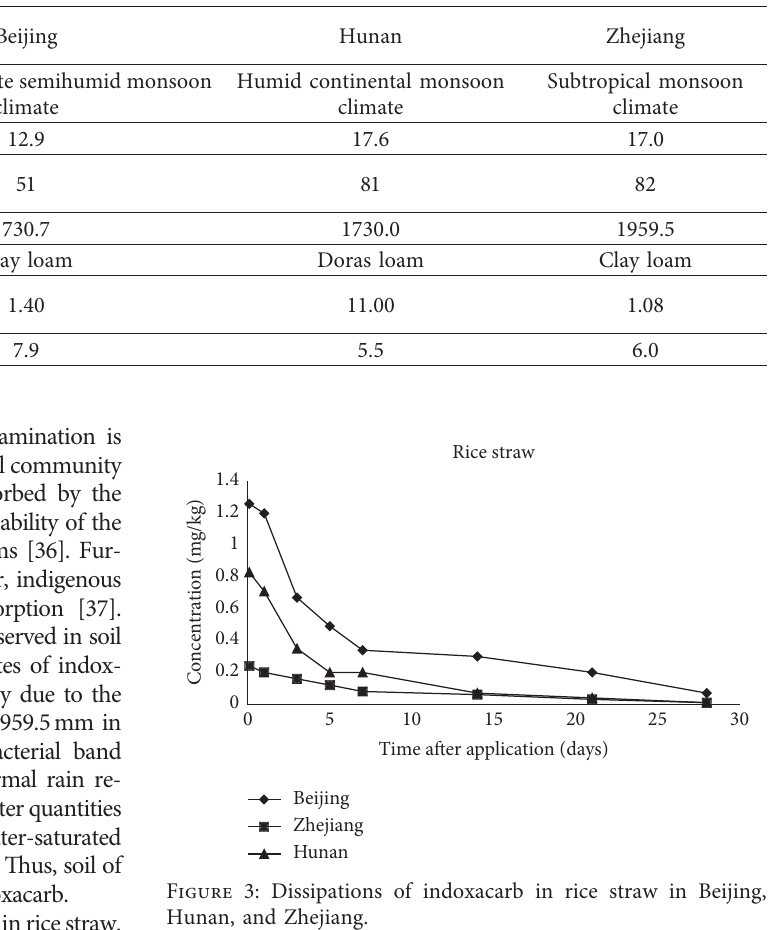
Figure 2: Dissipations of indoxacarb in paddy soil in Beijing, Hunan, and Zhejiang. Table 4: The field and environmental conditions in Beijing, Hunan, and Zhejiang.